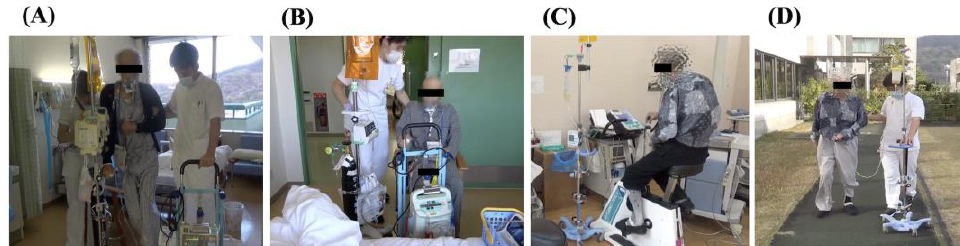
Figure 2. Postoperative rehabilitation. ( A ) Walking down the hallway for the first time at 11:30 am after discharge from the intensive care unit (postoperative day 1). ( B ) The patient was instructed to spend as much time as possible during the day in a sitting-chair position (6 h/day) outside of rehabilitation (postoperative day 1). ( C ) The patient resumes bicycle ergometer exercise while on continuous infusion with an enterostomy (postoperative day 7). ( D ) The patient is able to walk outdoors unassisted before discharge (postoperative day 26).